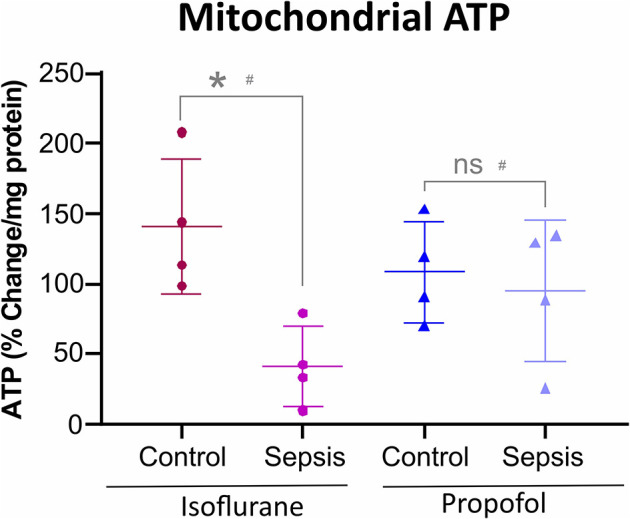
Anesthesia-Sepsis-associated changes in liver Mitochondrial ATP levels. Animals anesthetized with isoflurane-sepsis showed decreased mitochondrial ATP (adenosine triphosphate) levels (p* = 0.012), compared to controls, by Bioluminescent Assay. Whereas, animals anesthetized with Propofol-sepsis, showed no significant change (p = 0.670) in mitochondrial ATP content. n = 4# animals/group; Bars are mean ± S.D. #represents pooled samples.